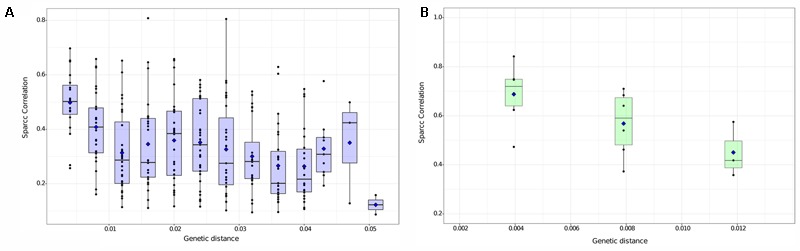
Co-occurrence of strains declines with their pairwise genetic distance. Relationship between co-occurrence (significant SparCC correlation, P < 0.05) and genetic distance (p-distance) between Dolichospermum
(A) and Microcystis
(B) nodes. Blue diamonds represents the mean SparCC correlation for each distance. Boxplots show the median (horizontal line), the 25th and 75th percentile (enclosed in box) and 95% confidence intervals (whiskers). The discreteness observed in the x-axis is due to the discrete number of substitutions in the 16S rRNA gene sequence (e.g., exactly 1, 2, 3, …nucleotide differences between pairs).